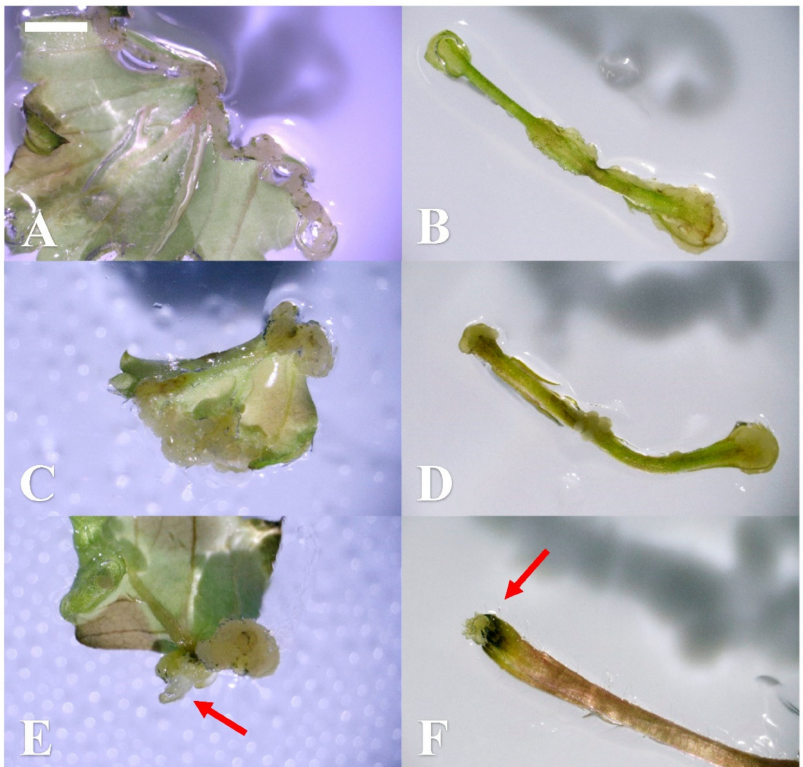
Figure 2. Callus induction and shoot regeneration using different explants (bar). After a 2-week culture, calli were found on ( A ) the whole leaf and ( B ) the petiole explants under the thidiazuron (TDZ) 4.53 µ M and 2,4-dichlorophenoxyacetic acid (2,4-D) 2.27 µ M combination (1 mm) in the dark condition. After a 4-week culture, both calli and shoots were observed. More calli were seen in ( C ) the whole leaf and ( D ) the petiole explants culture under the TDZ 2.27 µ M and 2,4-D 2.27 µ M combination (1 mm). The shoots started to develop in ( E ) the whole leaf and ( F ) the petiole explants culture under the TDZ 4.54 µ M and 2,4-D 0.45 µ M combination (1 mm). Table 2. Effect of the thidiazuron (TDZ) and 2,4-dichlorophenoxyacetic acid (2,4-D) combination on the callus induction rate from different strawberry ( Fragaria vesca ) explants after 2 weeks of culturing.